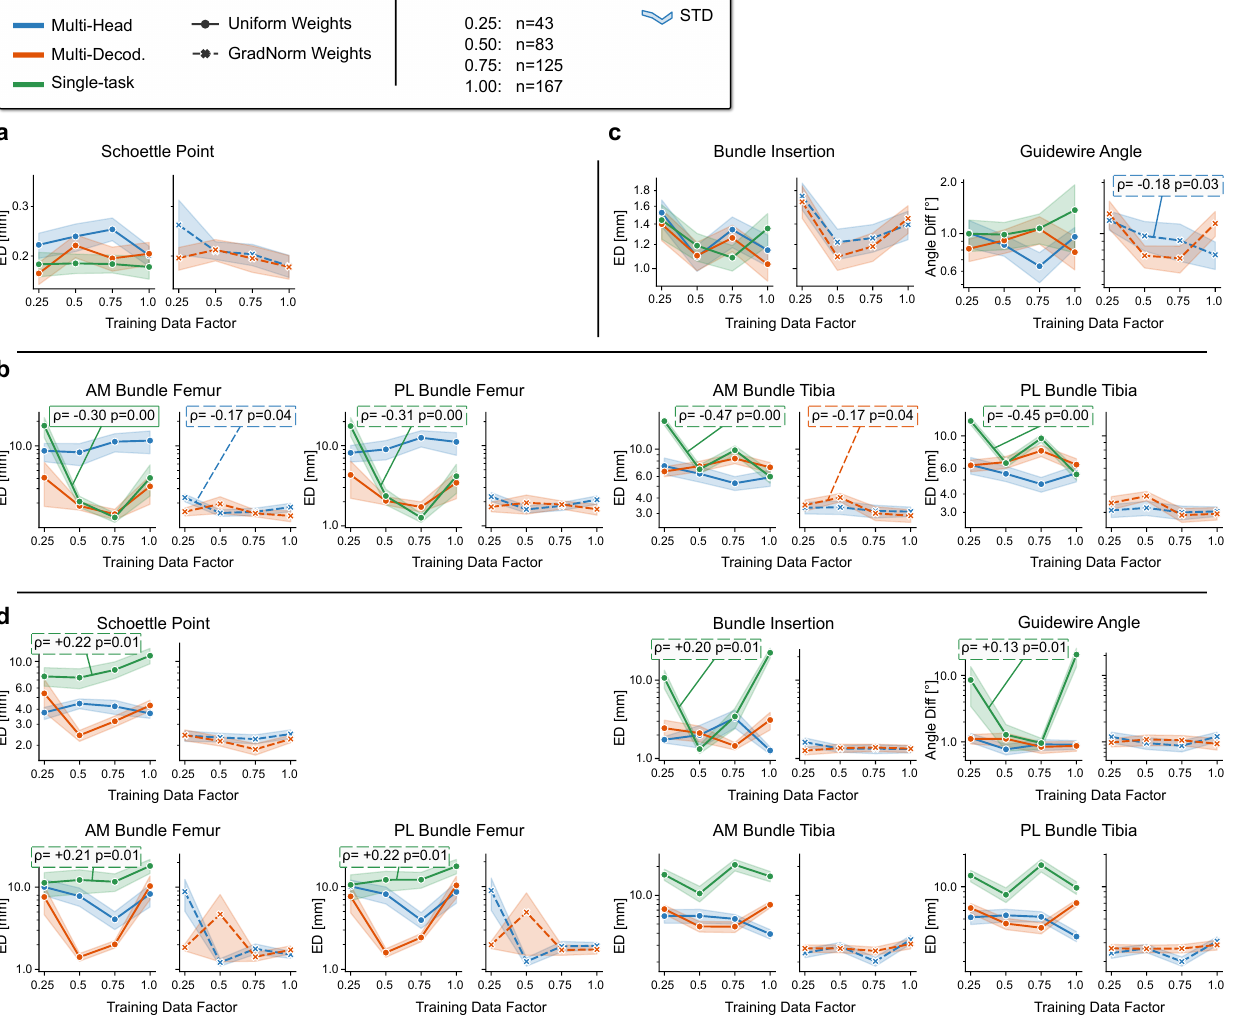
Figure 8. Effect of different amounts of training data on the planning metrics (logarithmic scale for y-axis for better visibility). ( a ), MPFL. ( b ), ACL. ( c ), PCL. ( d ), combined (MPFL, ACL, PCL). We report correlation coefficients ρ with rejection probability p < 0.05 based on two-sided Spearman’s rank correlation